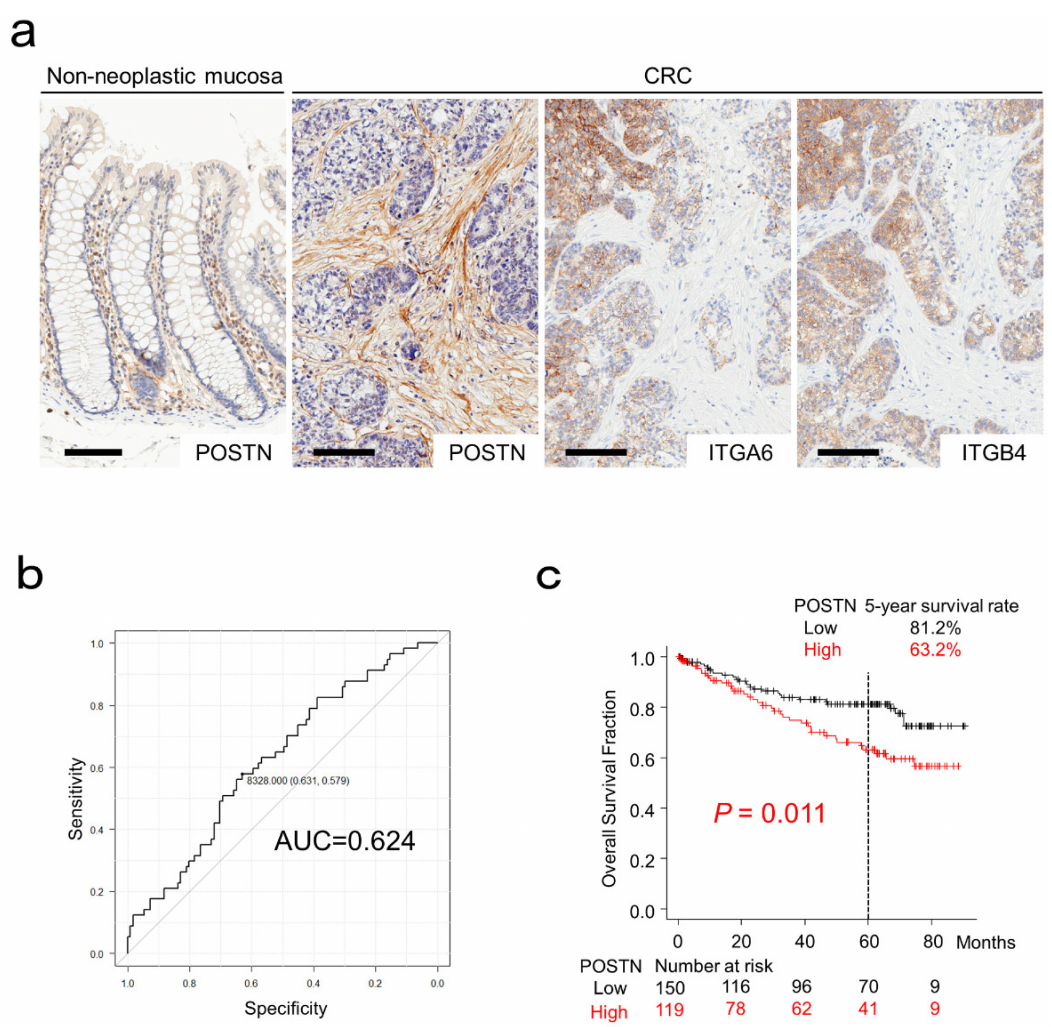
Figure 1. Expression and survival significance of periostin (POSTN) in colorectal cancer (CRC). ( a ) POSTN was weakly expressed on mesenchymal cells of non-neoplastic colonic mucosa. Note that non-neoplastic epithelial cells were negative for POSTN. Cancer-associated fibroblasts, but not CRC cells, expressed POSTN. ITGA6 and ITGB4, the canonical receptors for POSTN, were expressed in CRC cells. Bar, 100 µ m. ( b ) ROC curves for POSTN expression on the patient survival at 5 years. ( c ) Kaplan–Meier curves for patients classified by stromal POSTN expression. Table 1. Characteristics of colorectal cancers (CRCs) classified by stromal periostin (POSTN) expression. POSTN Total No. Positive Negative p